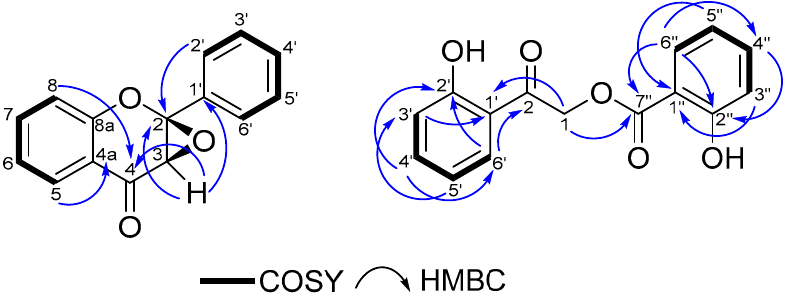
Figure 2. Key COSY and HMBC correlations of the two new phenolic compounds, 1 and 2 , from aerial part of D. diapensifolia . Table 1. 1 H- and 13 C-NMR Spectroscopic Data of 1 and 2 in CDCl 3 ( 1 H 600.19 MHz, 13 C 150.91 MHz).